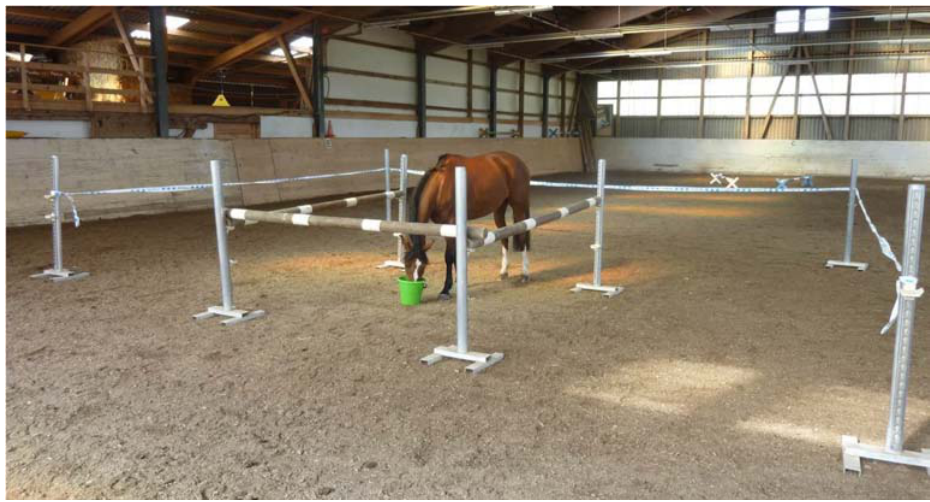
Figure 2. Horse feeding from the rewarded bucket after successfully completing the detour task.